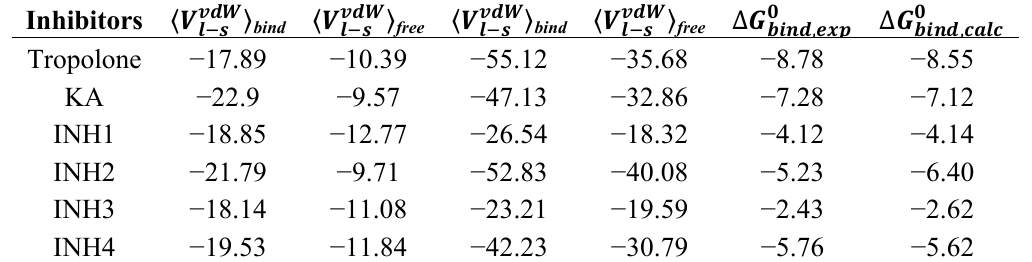
Table 5. Free energy terms values for LIE calculated for each enzyme-inhibitor complex and its experimental energy values *.